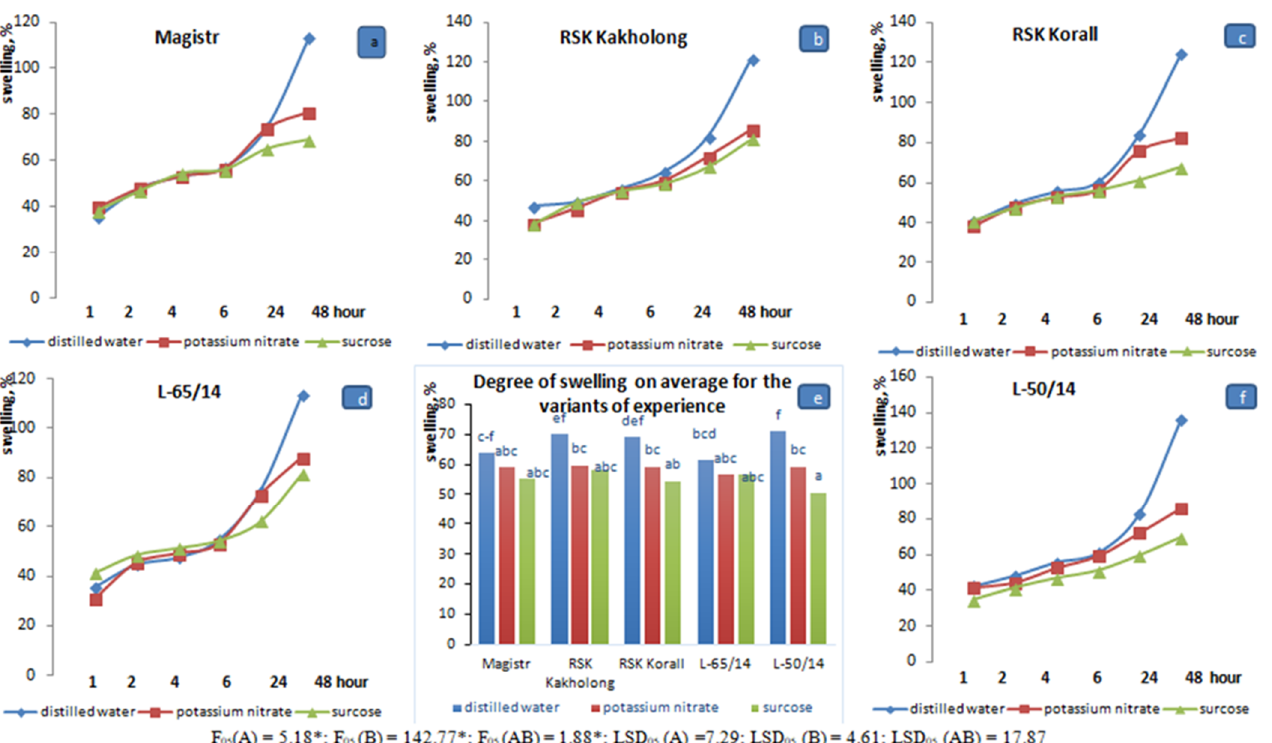
Figure 1. Dynamics ( a – d , f ) and average degree of seed swelling ( e ) of varieties and lines of grain sorghum (average for 2021–2022). Note: * p ≤ 0.05. Different letters indicate values that differ significantly from each other in the column or the table by comparison with the Dunn’s test.